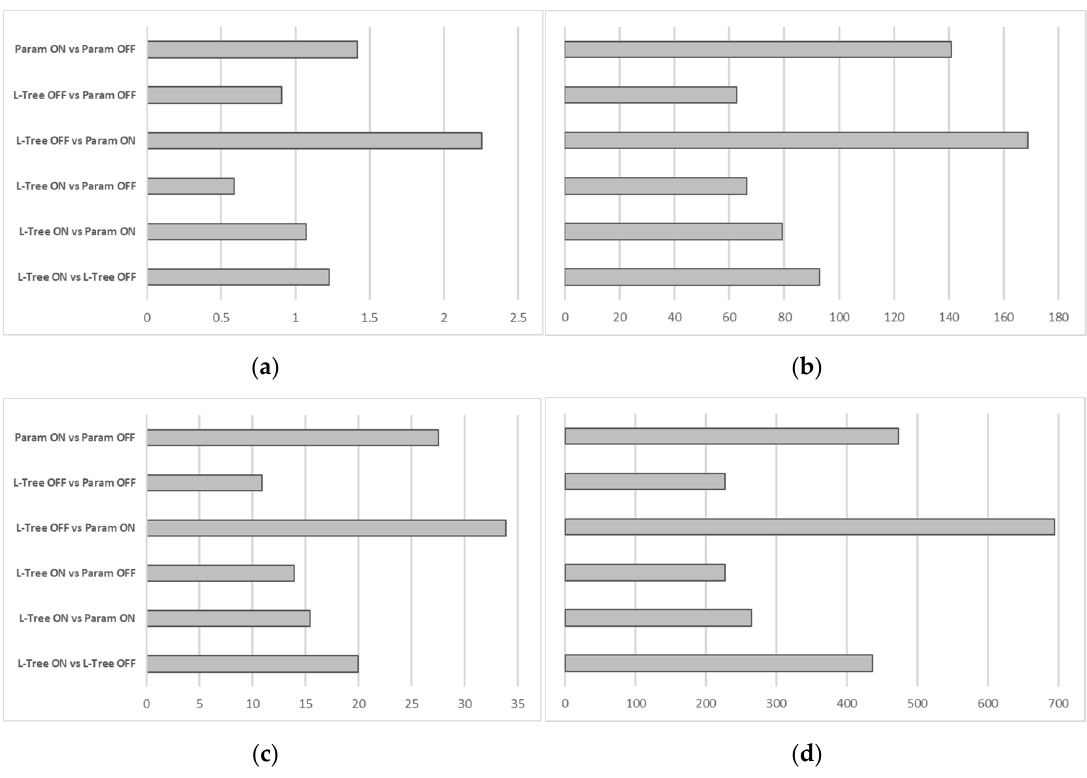
Figure 9. Root mean square error between different combinations of Parametric-Tree, L-Tree, and ACRT on and ACRT off: Maximum leaf temperature ( a ), average stomata resistance ( b ), latent heat flux ( c ), and average received photosynthetic radiation ( d ).